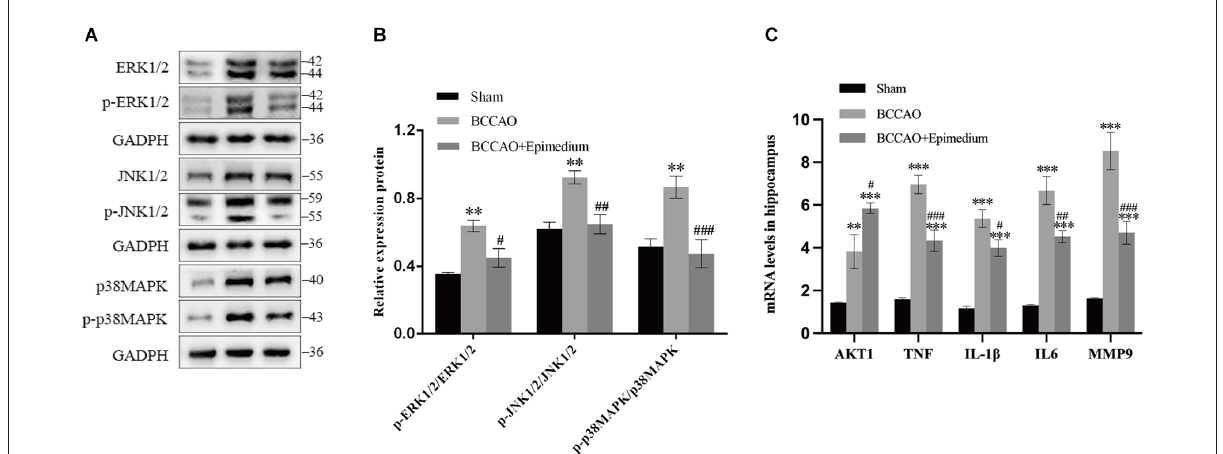
FIGURE12 Epimedium modulated the secretion of cytokines and activation of the MAPK/ERK/JNK pathways in VaD mice. The contents of AKT1, TNF, IL-1 β , IL-6, and MMP in the hippocampus ( C , n = 5) were analyzed by RT–qPCR. Western blotting was used to detect p-ERK1/2, ERK1/2, p-JNK1/2, JNK1/2, p-p38MAPK, and p38MAPK proteins in hippocampus ( A,B , n = 3). ∗∗∗ P < 0.001 and ∗∗ P < 0.01 vs. the sham group; ### P < 0.001, ## P < 0.01, and # P < 0.05 vs. the BCCAO